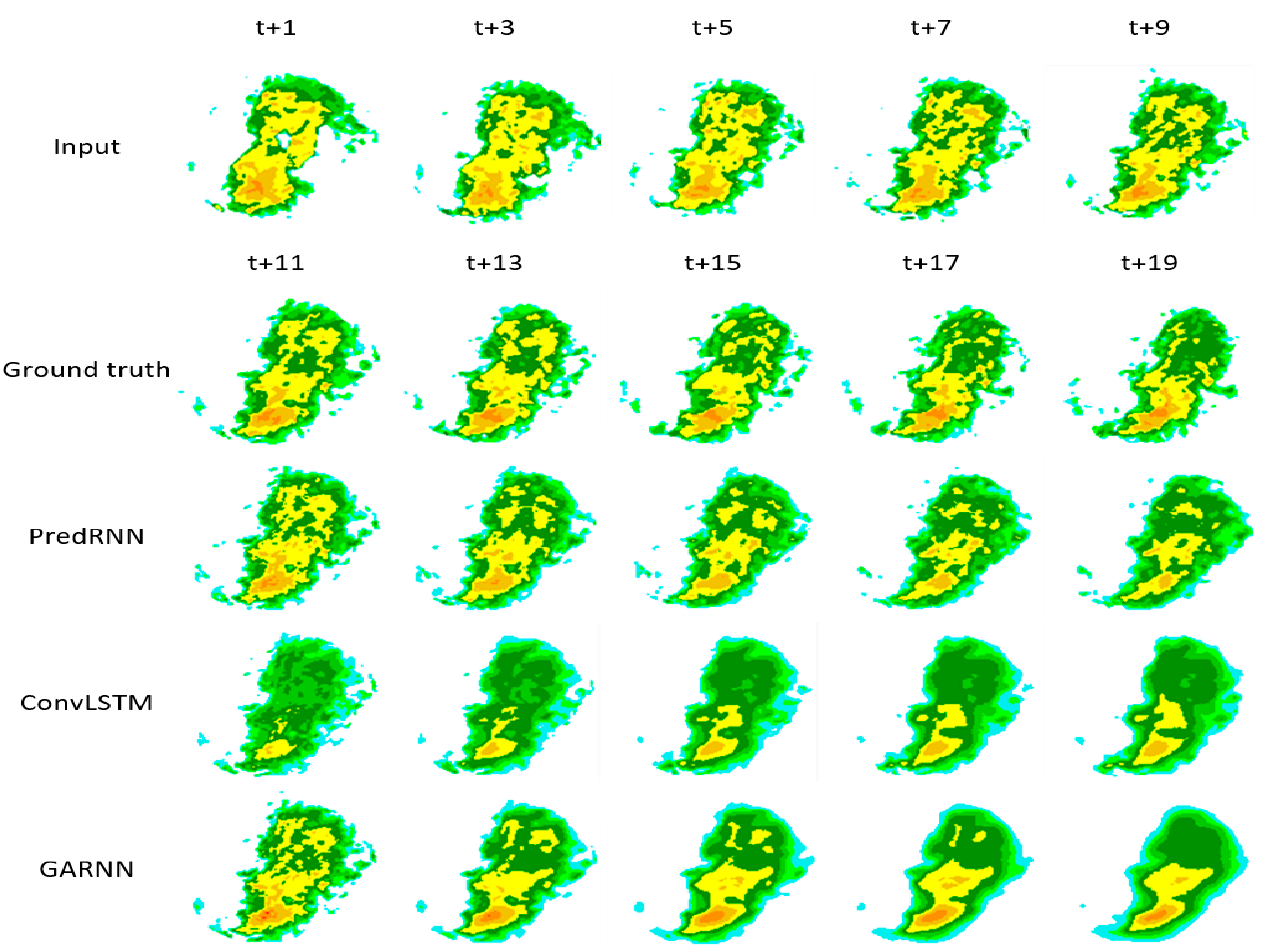
Figure 9. Example comparison of GARNN, ConvLSTM, and PredRNN predicting the echo map in the next 1 h.